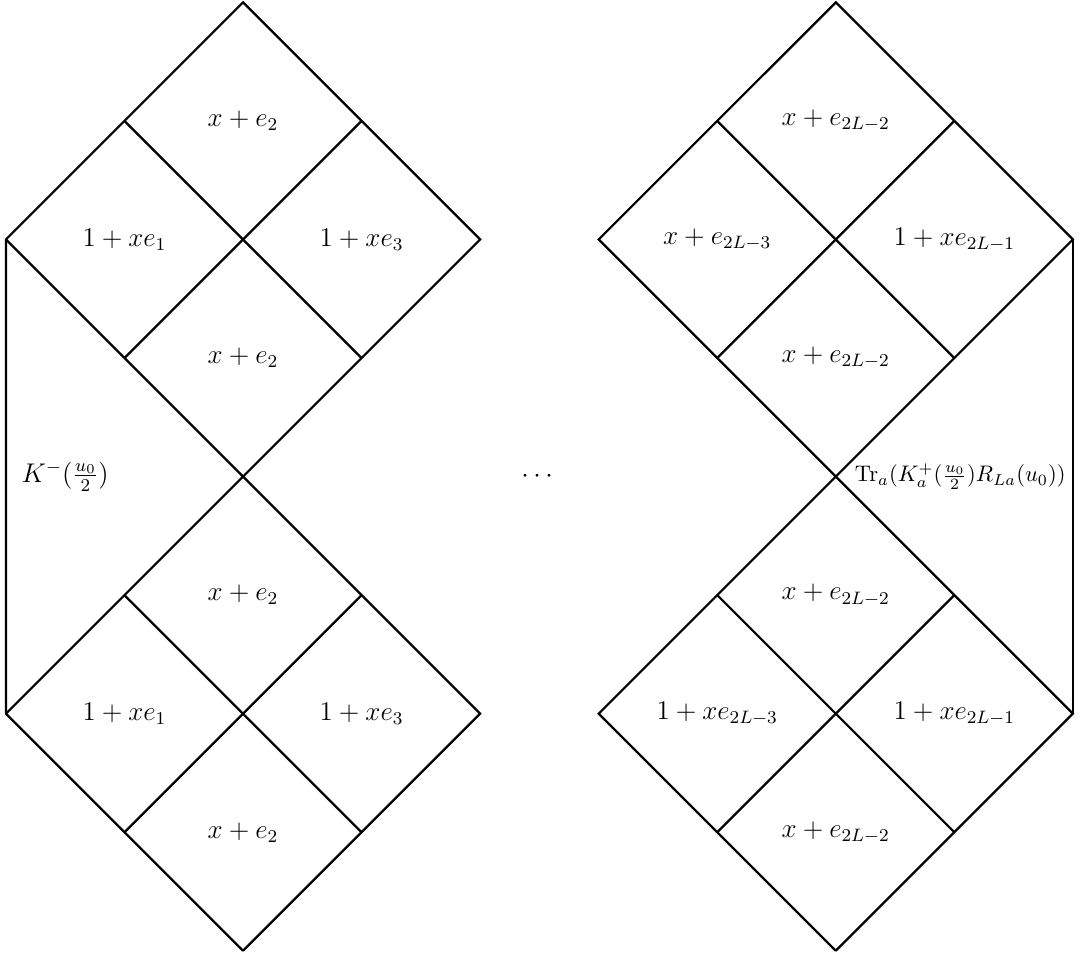
Figure 8 . Same as figure 7, but with the action of the R -matrix and K -matrix written at the place of each vertex, in terms of Temperley-Lieb